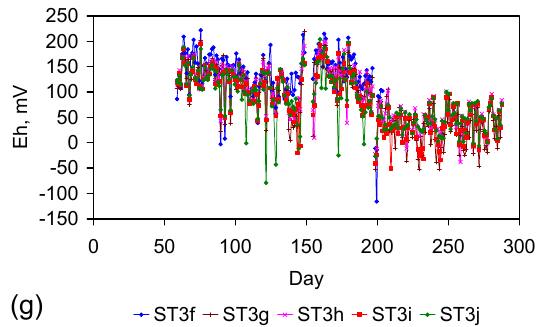
Figure C7. ( a ) pH vs. Eh; ( b ) EC vs. day, ST3a–ST3e; ( c ) EC vs. day, ST3f–ST3j; ( d ) pH vs. day, ST3a–ST3e; ( e ) pH vs. day, ST3f–ST3j; ( f ) Eh vs. day, ST3a–ST3e; ( g ) Eh vs. day, ST3f–ST3j. ZVM TP = copper sheathed pellets (15 mm OD) placed in water at a